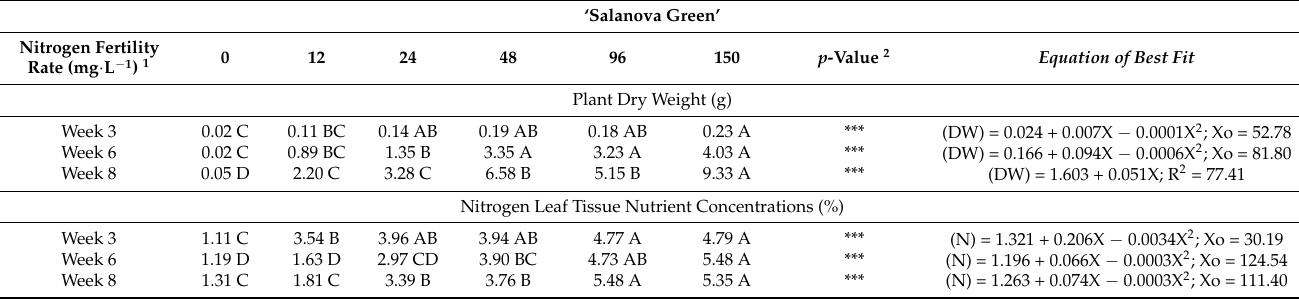
Table 2. Impact of nitrogen fertility rate on plant dry weight and nitrogen leaf tissue concentration on ‘Salanova Green’ lettuce. ‘Salanova